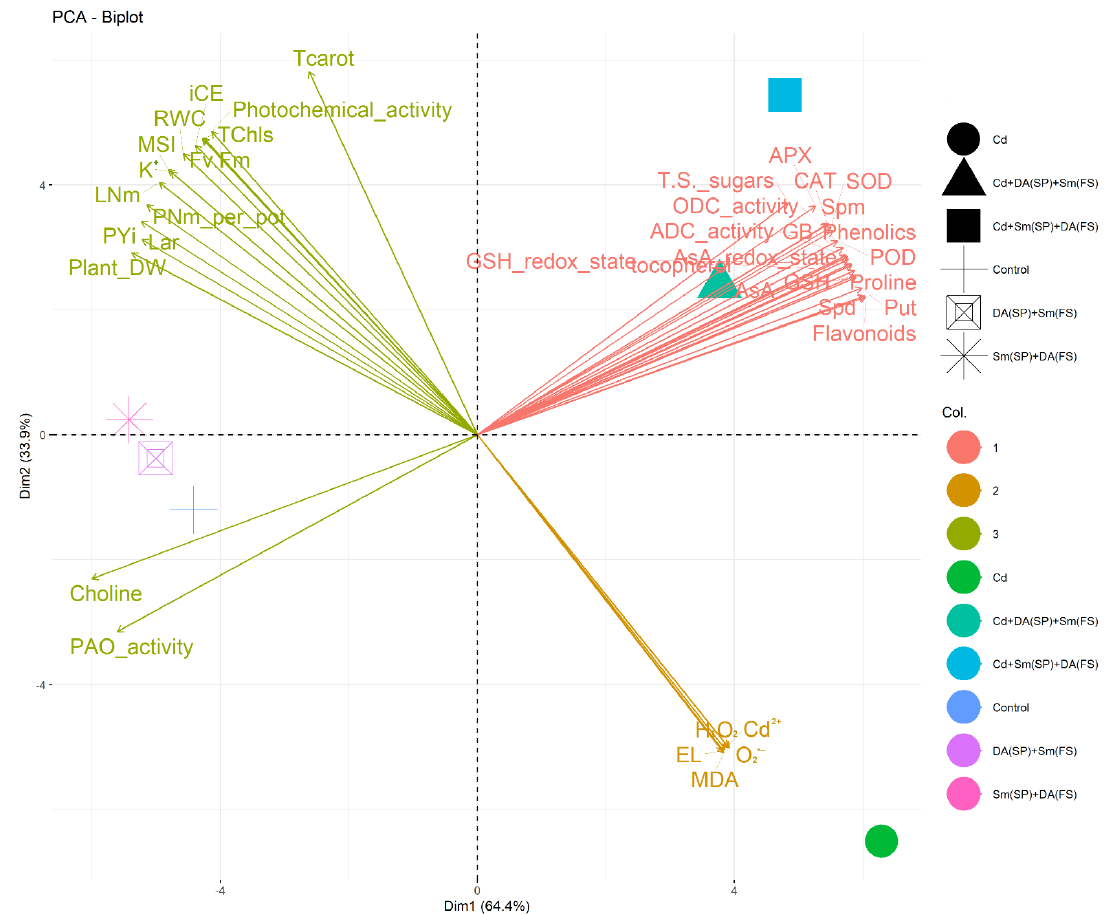
Figure 11. Biplot graph of different parameters studied for each treatment, showing the first two dimensions (Dim1 and Dim2) of the principal component analysis (PCA) model in Phaseolus vulgaris plants treated with silymarin (Sm) and dopamine (DA) as seed priming (SP) and foliar spraying (FS) under cadmium stress conditions. TChls = Total chlorophyll, TCarot = Total Carotenoids, iCE = in- stantaneous carboxylation efficiency, Fv/Fm = chlorophyll “a” fluorescence, LNm = leaf number, LAr = leaf area, DW = dry weight, PNm = pod number, PYi = pod yield, AsA = Ascorbate, GSH = Glutathione, O 2 •‒ = Superoxide, H 2 O 2 = Hydrogen peroxide, MDA = Malondialdehyde, EL = Electro- lyte leakage, RWC = Relative water content, SOD = Superoxide dismutase, CAT = Catalase, APX = Ascorbate peroxidase, POD = Peroxidase, Put = putrescine, Spd = Spermidine, Spm = Spermine, ADC = Arginine decarboxylase, ODC = Ornithine decarboxylase, and PAO = Polyamine oxidase.